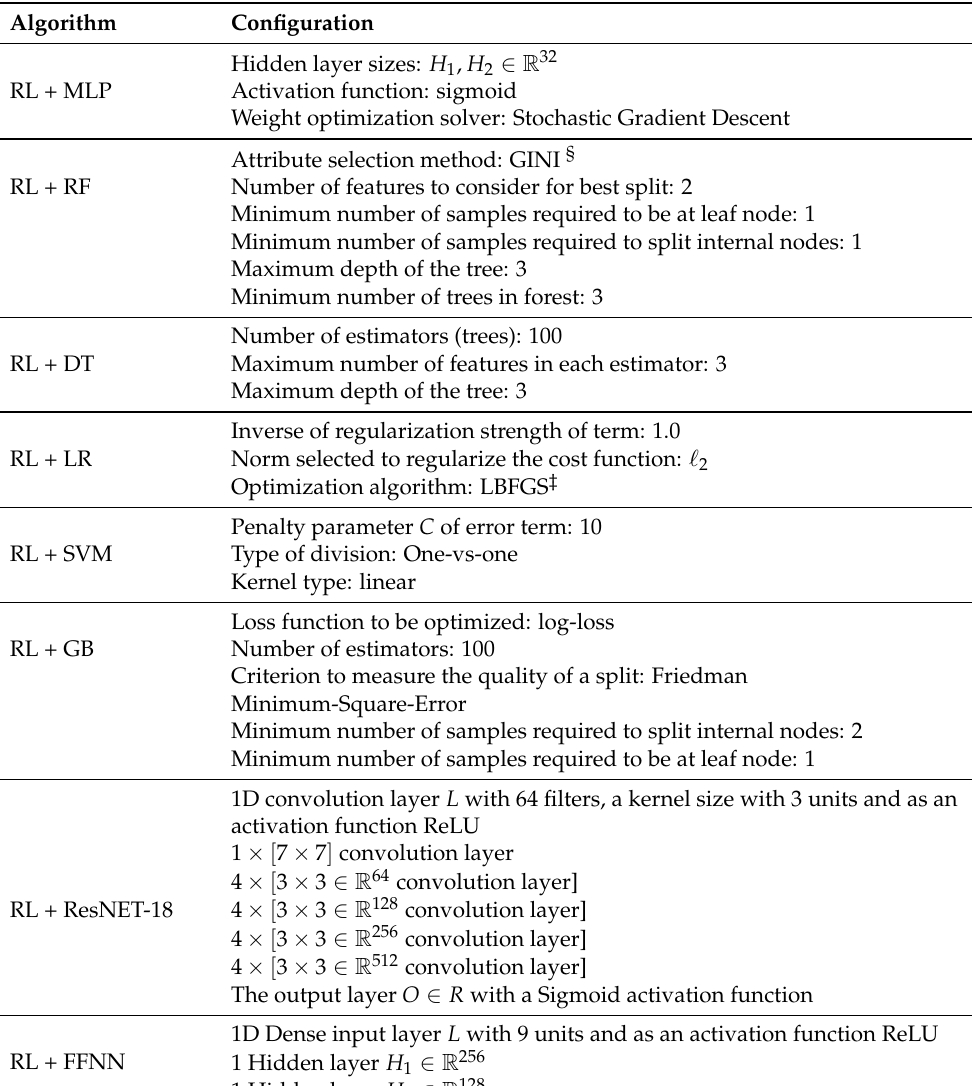
Table 8. State-of-the-art reported SL and DL algorithm configurations for comparison with this work (RL).